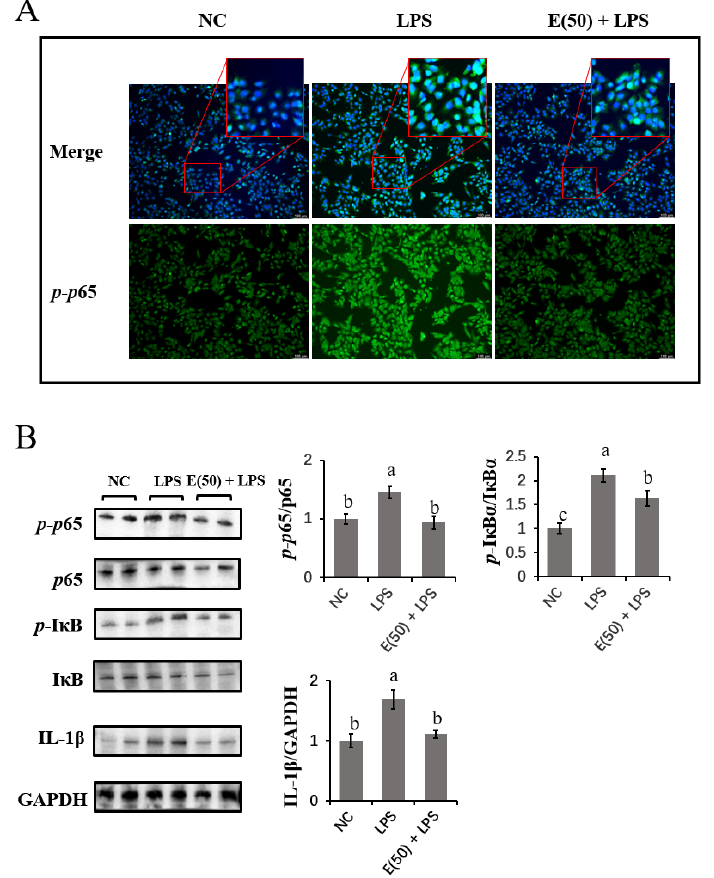
Figure 3. The effect of EGCG pretreatment on LPS-induced NF- κ B signaling components. The concentration and timing of EGCG treatment of cells were selected as 24 h at a concentration of 50 μ M. ( A ) Immunofluorescence of p - p 65 proteins expressed in hepatocytes and imaged using DMi8 Microsystems BmbH. Cells were observed at 200 × magnification. ( B ) Immunoblots were determined for the expression of proteins related to NF- κ B signaling and pro-inflammatory cytokine. Experiments were performed as three independent replicates. Results are expressed as means ± S.E.M. Letters in superscript indicate that the difference between groups was significant ( p < 0.05).